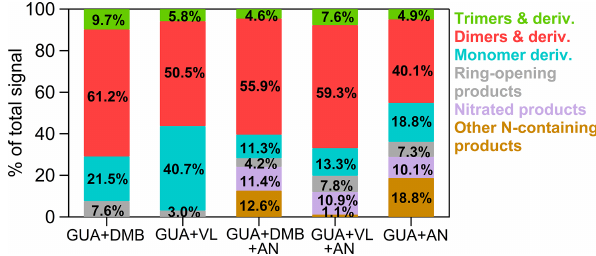
Figure 2. Signal-weighted distributions of aqSOA from GUA + DMB, GUA + VL, GUA + DMB + AN, GUA + VL + AN, and GUA + AN. These product distributions were calculated from combined UHPLC-HESI-Orbitrap-MS data obtained in positive (POS) and negative (NEG) ion modes. The values indicate the contribution of different product classifications to the total signals for each reaction